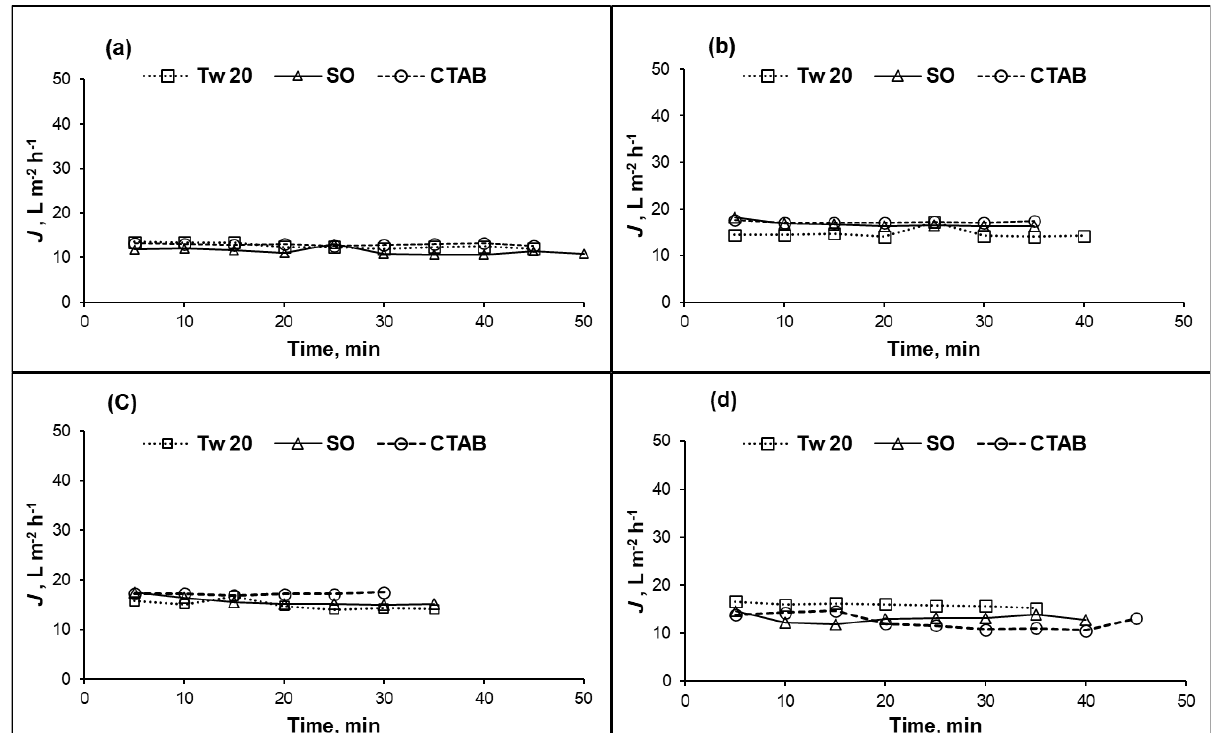
Figure 3. Permeate flux ( J ) of CA membrane versus time at different surfactant concentrations: ( a ) 100 mg/L; ( b ) 500 mg/L; ( c ) 1000 mg/L; and ( d ) 10,000 mg/L; (10% recovery ratio, operating pressure = 1.5 MPa, temperature = 25 °C).